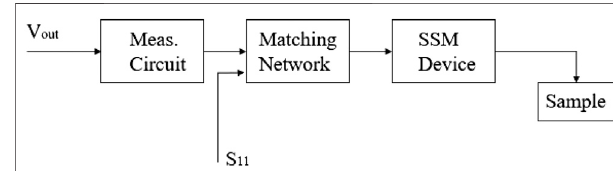
FIGURE 6 | Block diagram of the SMM